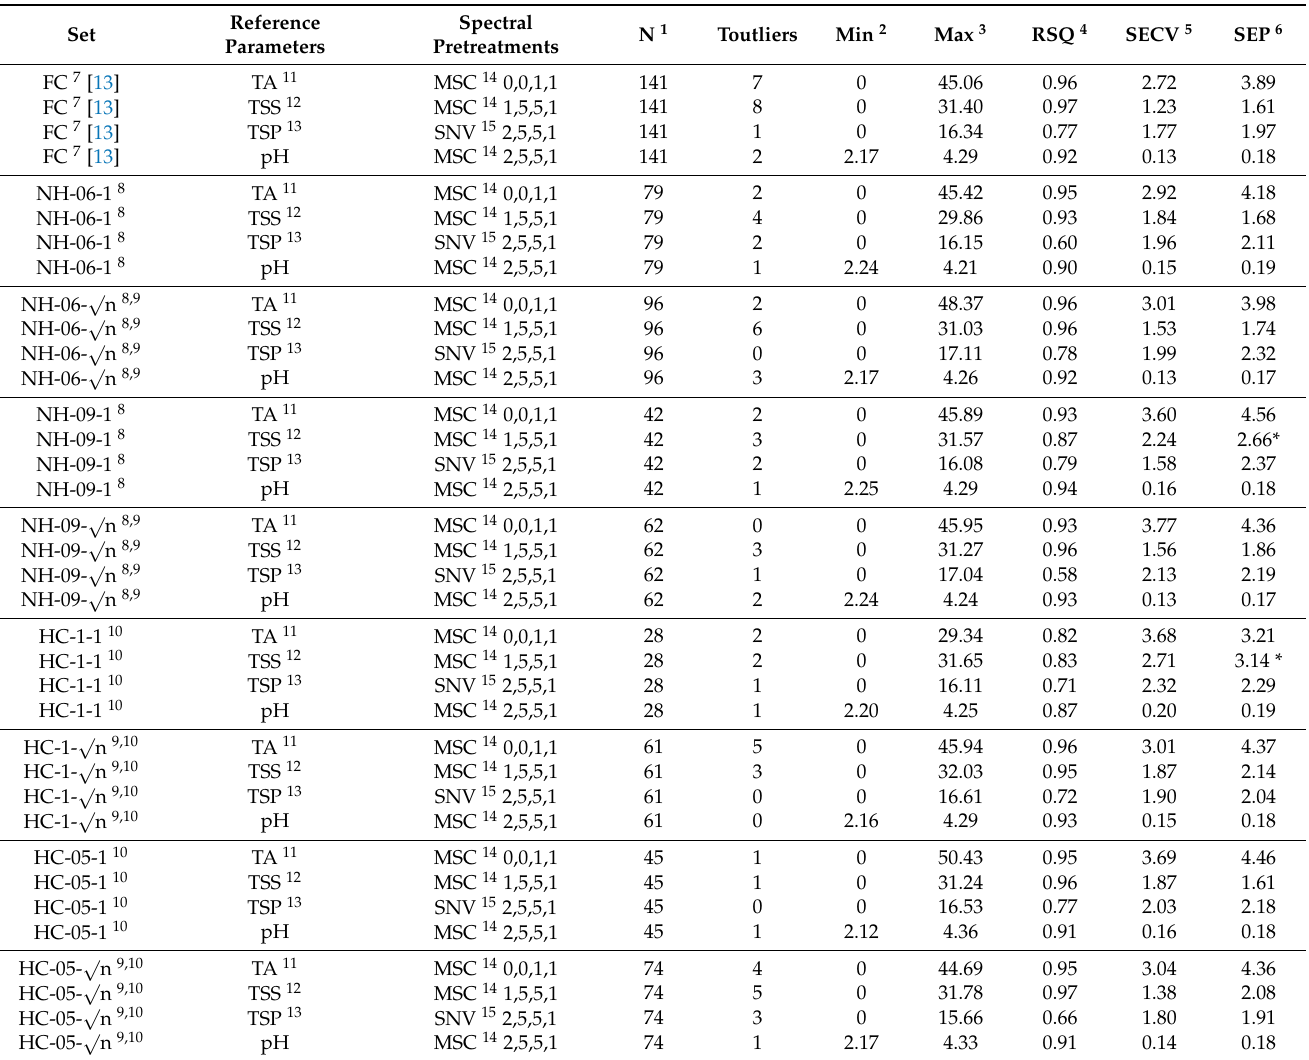
Table 1. Main statistical parameters for the different Modified Partial Least Square (MPLS) calibrations. In the standard errors of prediction (SEP) column, asterisks (*) indicate statistically significant differences ( α = 0.05%) with the corresponding full calibration (FC)